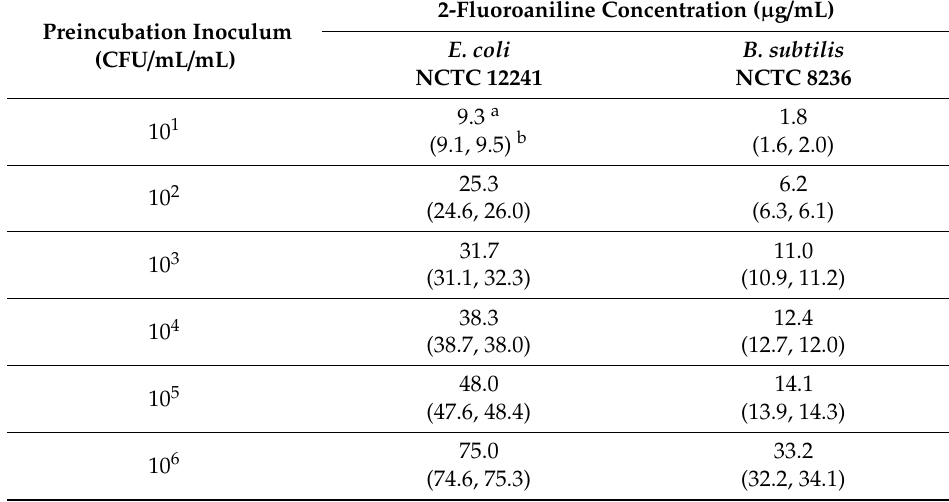
Table 3. The 2-fluoroaniline concentrations detected from various inocula following